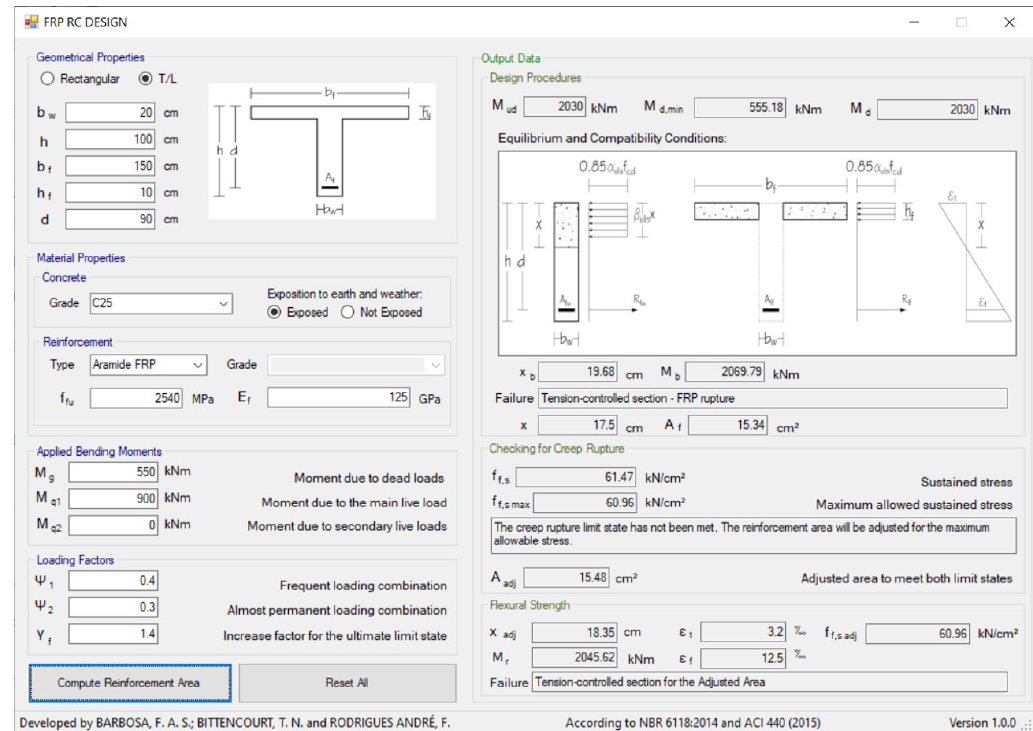
Figure 12. Computation of the AFRP reinforcement area using the developed design